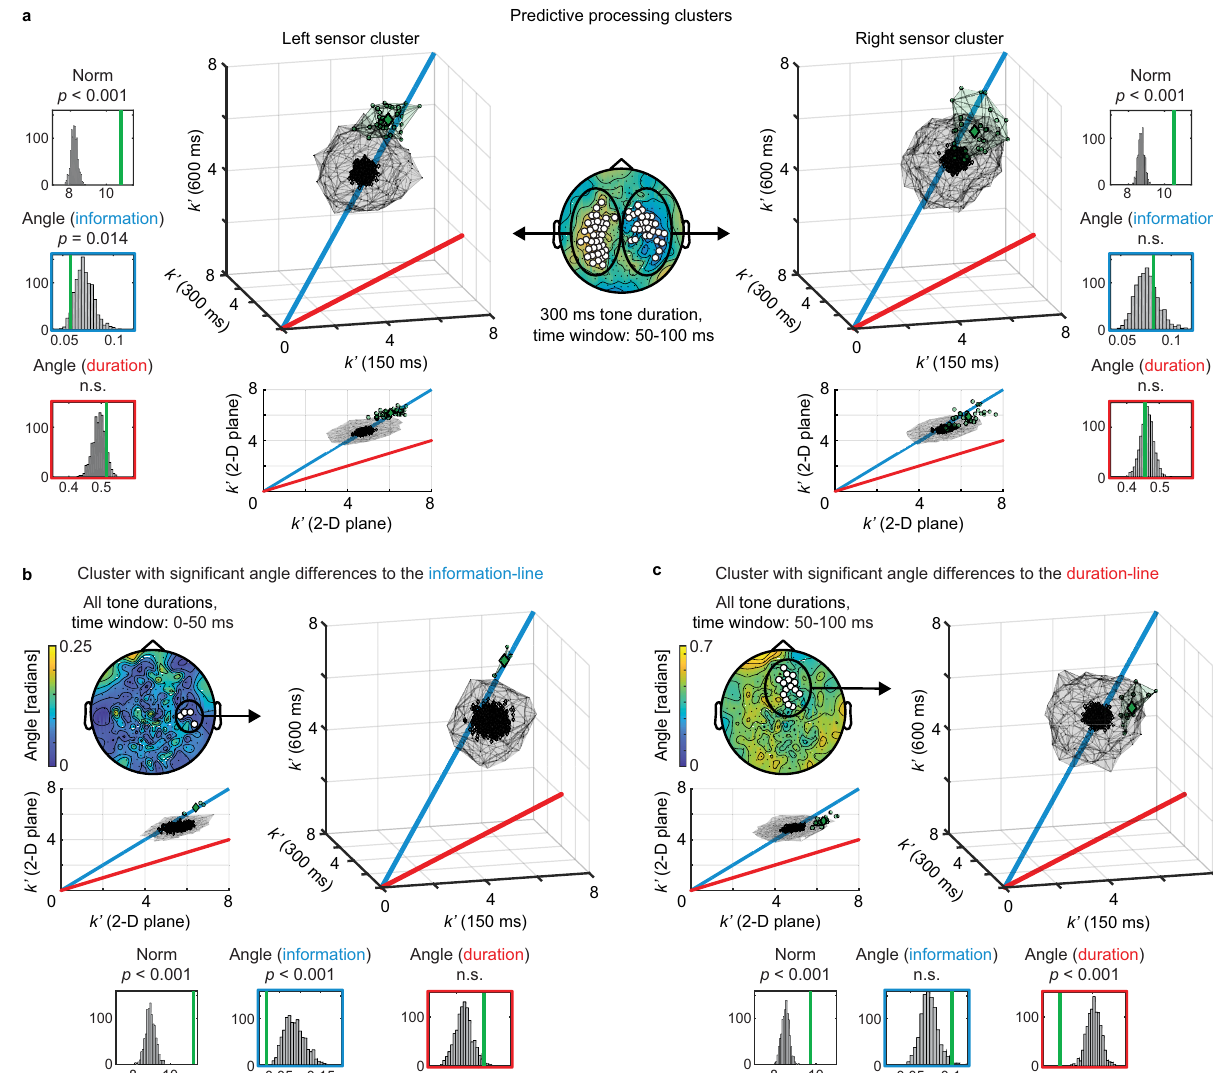
that SHI underlying predictive computation operates over a fi xed amount of information. For vector angle towards the duration line, an anterior-central sensor cluster where angles were signi fi cantly smaller than expected under the null distribution was present from 0 – 100 ms (Fig. 5c; 0 – 50 ms: